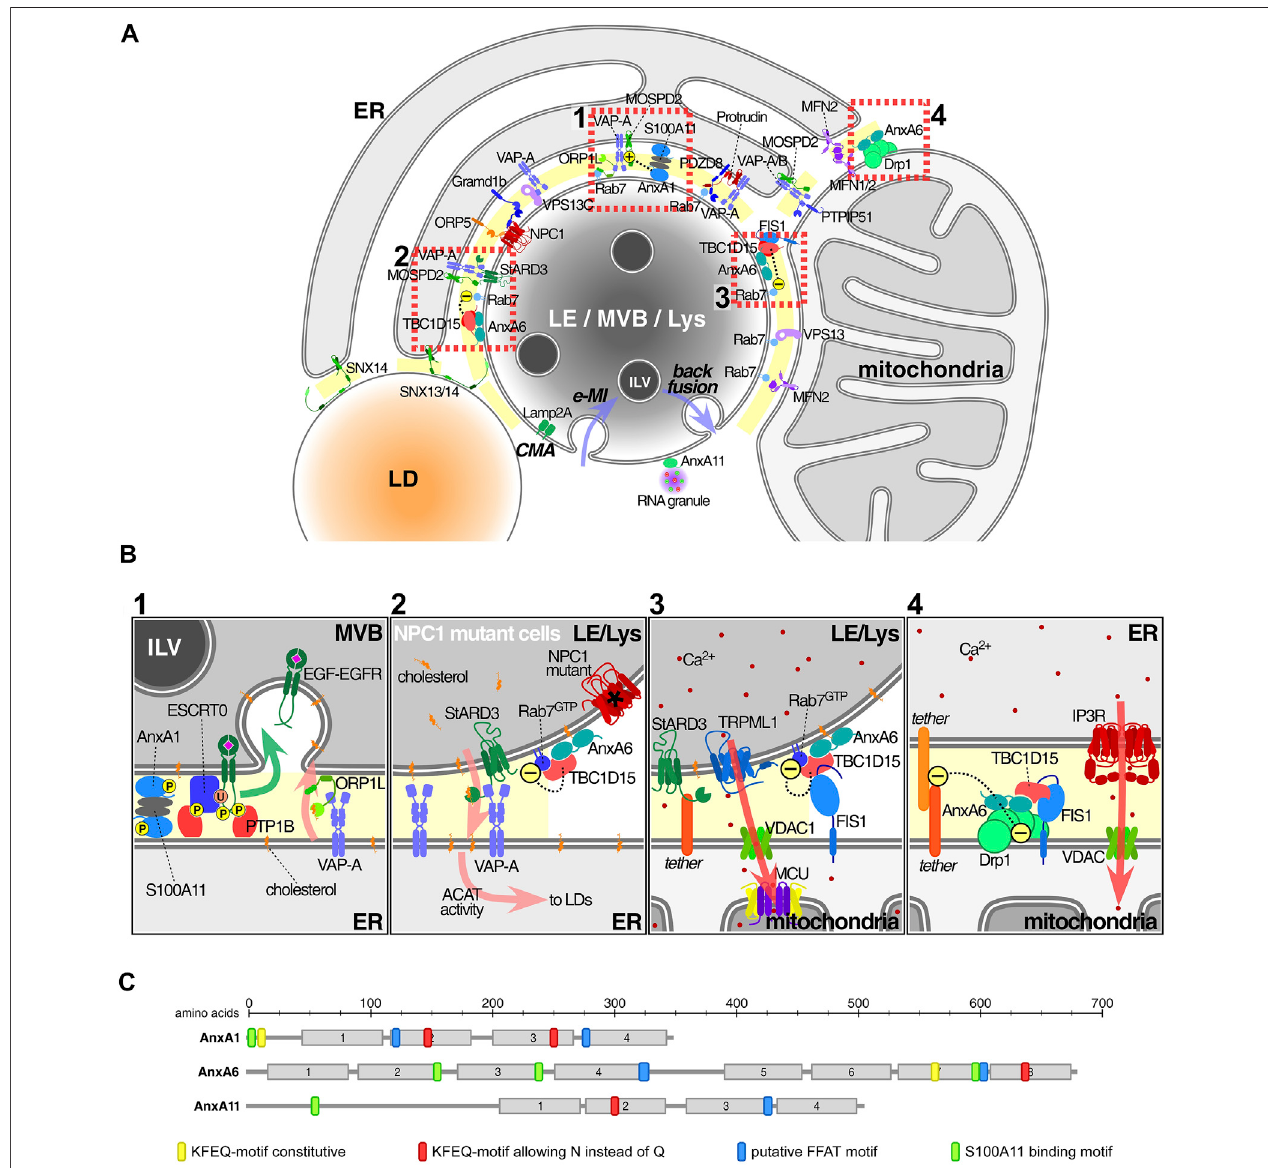
FIGURE 1 | Annexins and associated protein complexes at membrane contact sites. (A) Endolysosomes (LE/MVBs/Lys) establish multiple membrane contact sites (MCS) with a variety of other organelles, in particular the ER and mitochondria, but also peroxisomes and lipid droplets. Here we only illustrate a subset of contacts and contact site proteins. Lipid transfer, including cholesterol as well as Ca 2+ mobilization and signalling are probably the most important MCS-associated functions. Annexins have been found in MCS connecting the ER with either LE or mitochondria (MAMs), as well as in LE-mitochondria contacts. Other proteins or protein complexes serve as tethers to ensure the formation of MCS, including several sorting nexins (Henne et al., 2015; Dong et al., 2016; Saric et al., 2021), VAP proteins, PTPIP51, PDZD8 or protrudin (Shirane et al., 2020; Neefjes and Cabukusta, 2021). Furthermore, ORP5/8 and NPC1/Gramd1 also translocate lipids including PS and cholesterol, acrossMCS between theER and mitochondria and/or LE respectively (Galmeset al., 2016; Hoglinger et al., 2019).Atthe bottom ofthis endolysosome, we contemplate the possible recruitment of cytosolic annexins into ILV (see text for details) via two autophagic pathways. While chaperone-mediated and Lamp2a- dependent autophagy (CMA) may carry annexins into the lumen of MVBs or the outer membrane of ILVs, endosomal microautophagy (e-MI) may board annexins inside ILV (both routes via KFERQ-motif) (Tekirdag and Cuervo, 2018). In any case, whatever the topology, these proteins have to escape from lysosomal degradation (Meneses-Salas et al., 2020b). Then, ILV might undergo back fusion/retrofusion (Eden and Futter, 2021), delivering annexins and/or other cargo out of the MVB into the cytosolinthevicinityofMCS,whereasuitablelocalCa 2+ andlipidmicroenvironmentcouldthenfavourretentioninMCS.Alternatively,MVBdiversiontoexocytosiscould generate exosomes. This could be the destination of AnxA11, highly enriched in exosomes. Otherwise, cytosolic AnxA11 could be con fi ned to PI(3,5)P2 at the endolysosomal cytosolic membrane to tether RNA granules (Liao et al., 2019). (B) 1 : AnxA1, together with S100-A11 as a tetrameric complex, tethers MCS to mediate cholesterol transport from ER to LE/Lys via interaction of VAP-A with ORP1L (Eden et al., 2016). In this scenario, AnxA1 overexpression increases MCS between MVB and ER (Wong L. H. et al., 2018). 2 : AnxA6 overexpression decreased MCS numbers between ER and LE/Lys, whereas AnxA6 depletion in NPC1 mutant cells stimulatedMCS formation. The underlying mechanism involves the recruitment of AnxA6and TBC1D15toRab7-positive organelles and was associated withincreased ( Continued )